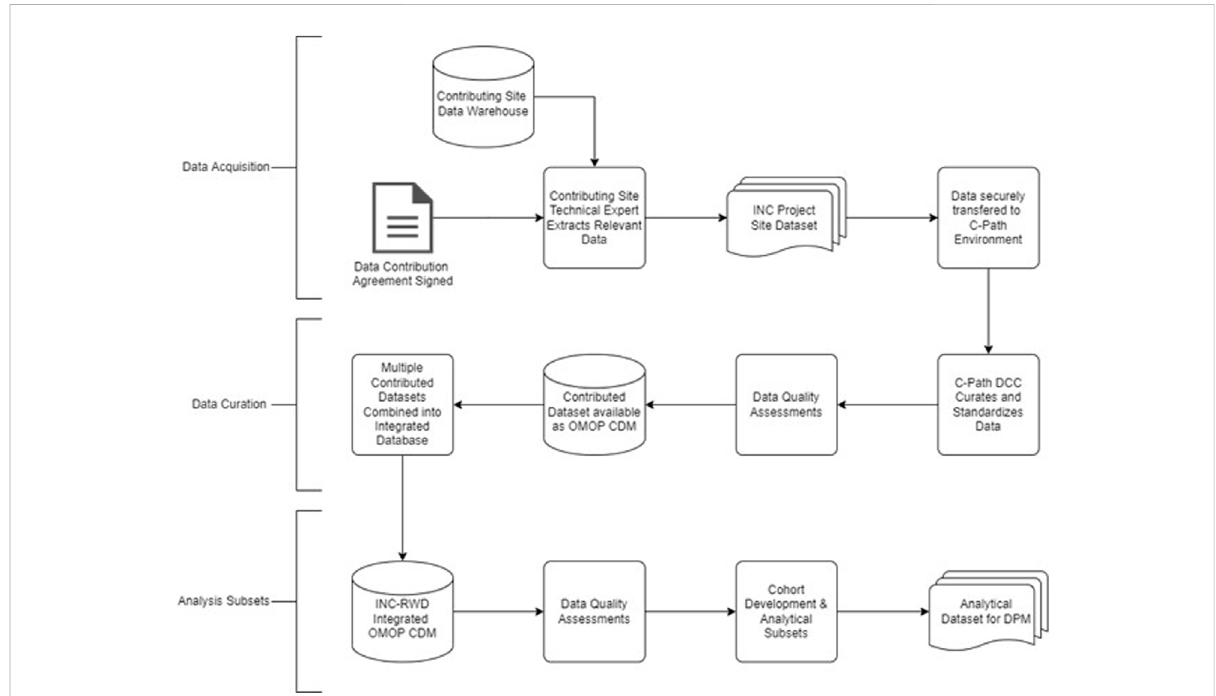
FIGURE 3 Data fl ow diagram to generate analytical subset from contributed real world data.